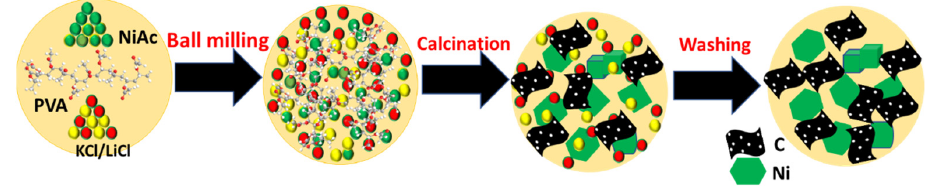
Figure 1. ( a , b ) Low- and high-magnification of FESEM images and ( c , d ) TEM and HR-TEM images of Ni NPs/PCFs.